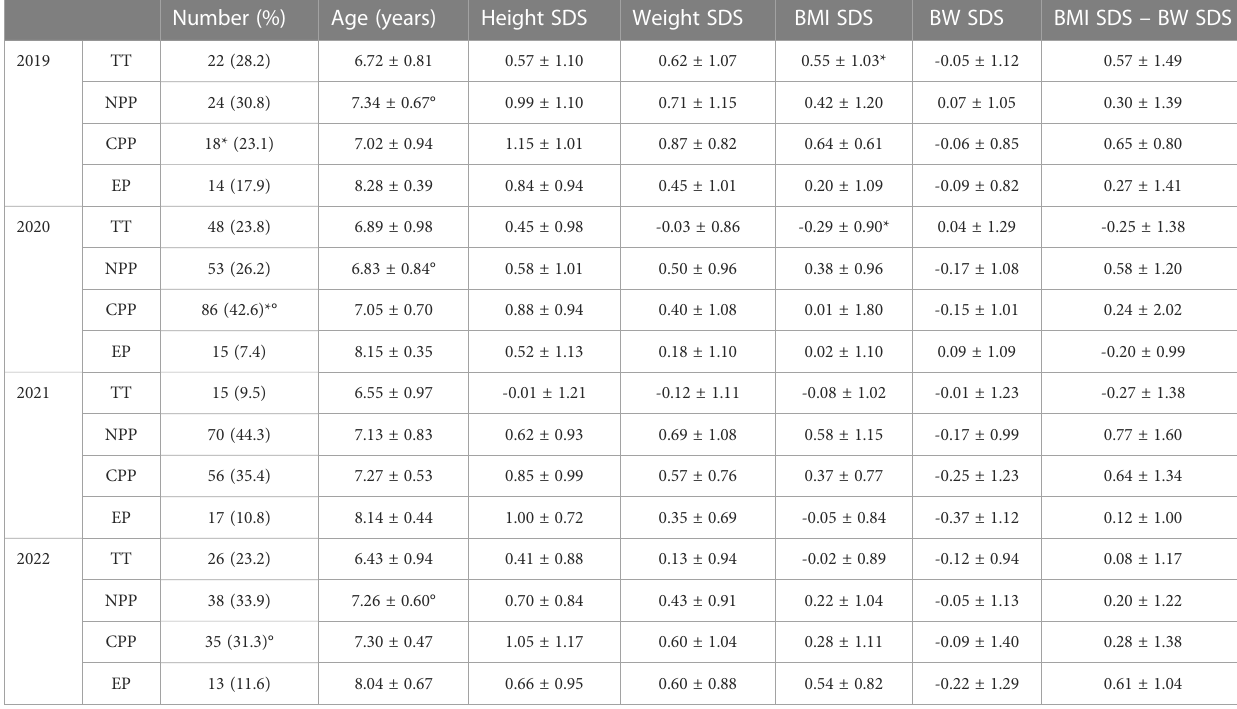
TABLE 2 Anthropometric parameters of study population according to year of observation and fi nal diagnosis.